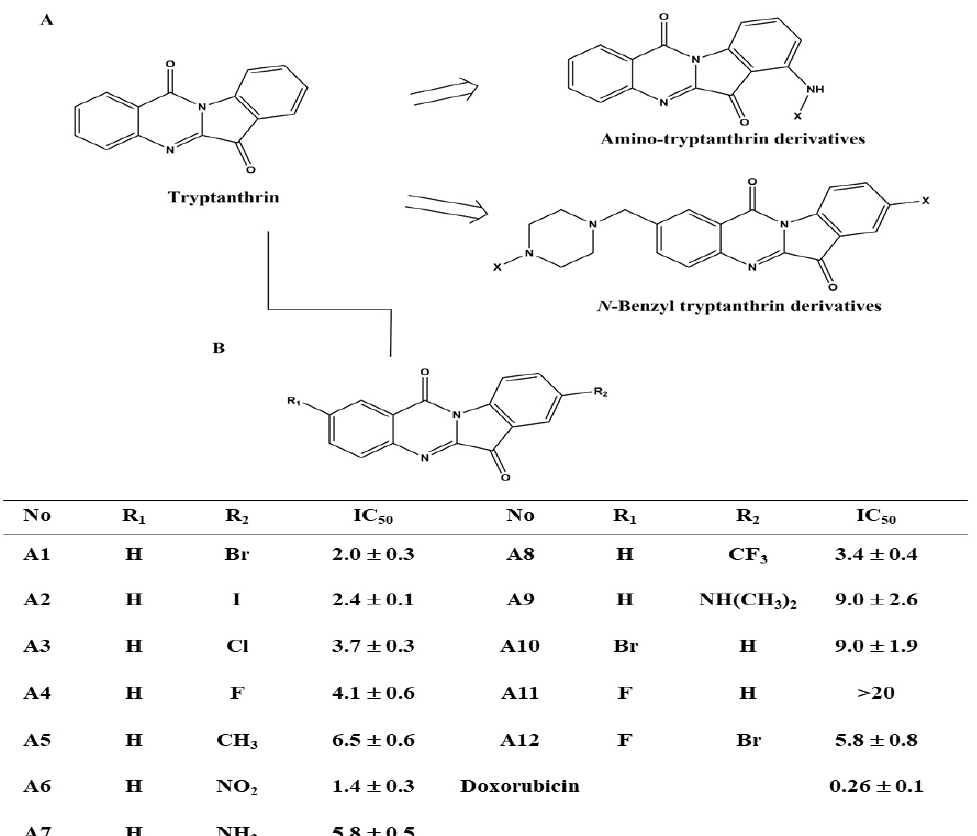
Figure 1. Tryptanthrin as the lead compound to synthesize anti-tumor agents. ( A ) Structure of tryptanthrin. ( B ) Structures and potencies of the tryptanthrin derivatives (A1–A12) in Hep3B cells. Cell viability was examined via MTT assay and the IC 50 values were measured 50% relative to